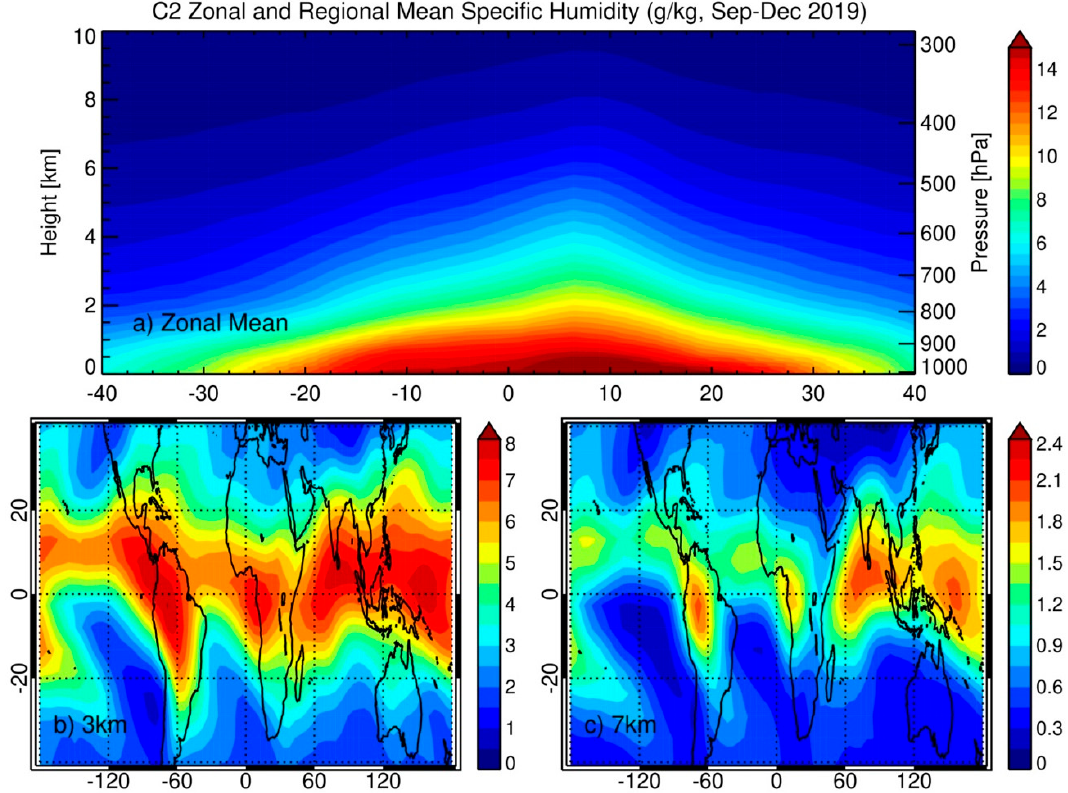
Figure 2. ( a ) C2 zonal mean specific humidity (g/kg), along with the C2 specific humidity at ( b ) 3 km and ( c ) 7 km within 40° N–40° S from September–December 2019. The zonal mean humidity percentage differences between C2 and ERA5 along with C2 and MERRA-2 are analyzed between 40 ° N–40 ° S in Figure 3. Profile pairs are placed within 2.5 ° latitude bands and humidity percentage differences are calculated and aver- aged to obtain a better idea of which latitudes and tropospheric heights show the largest differences. The C2 and ERA5 comparison (Figure 3a) shows that C2 has a negative spe- cific humidity bias within the boundary layer (–6% to –12%). These differences occur due to well-known issues with RO within the boundary layer, as large refractivity changes associated with a strong inversion layer at the top of the planetary boundary layer (PBL) can lead to super-refraction and various receiver tracking errors which cause negative bi- ases in RO refractivity measurements [18,20]. Just above the boundary layer, C2 and ERA5 SHs show excellent agreement. As heights increase, the C2 bias becomes positive and the maximum bias (9% to 12%) is observed in the Northern Hemisphere tropics between 8 km and 9 km. C2 and MERRA-2 moisture differences (Figure 3b) within the lower tropo- sphere are similar to those of C2 and ERA5, with negative bias observed in the boundary layer (–9% to –15%) and good agreement just above the boundary layer. However, as heights increase, SH differences increase rapidly and a large negative bias is observed, similar to Rieckh et al. [34]. Bias is especially large in the tropics (generally between –24% to –30%) and decreases into the subtropics (between –12 to –21%). The most likely expla- nation for these large differences in the tropical upper troposphere is due to the parame- terization of large-scale condensation and evaporation within the atmospheric general cir- culation model (AGCM) used in MERRA-2. This parameterization scheme contains a se- ries of new settings that result in a substantial increase in the evaporation of cloud ice crystals [35], leading to higher than expected specific humidity values throughout the up- per troposphere (especially in the tropics).